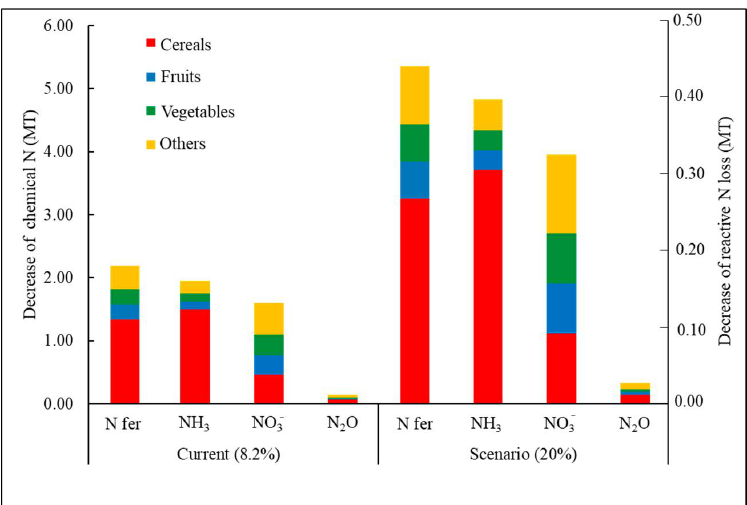
Figure 7. Achievable reduction in chemical N input (N fer), ammonia volatilization (NH 3 ), nitrate leaching (NO 3 − ), and nitrous oxide emission (N 2 O) if the proportion of green food in China increases to 20%.